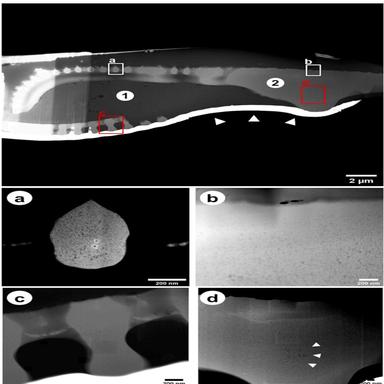
TEM dark field images. Cross-section of Didymosphenia geminata frustule: (1) epoxy filling, (2) frustule, white arrowheads: Pt protection layer; (a) single rib with increased contrast to visualize the pores; (b) central area with dense layer on outside; (c) other rib shows also uneven distribution of pores; (d) central area close to stigma with some bigger pores (white arrowheads) (adapted from).